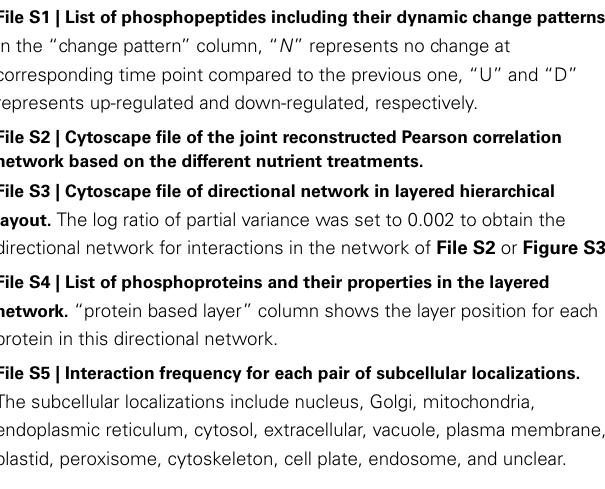
Figure S2 |Distribution of Pearson correlation coefficients associated with the actual experimental data (black) and randomized data (red lines, 1000 randomizations). Figure S3 | Subcellular location pair frequency network derived from AtPIN and SUBA. The width of each edge is proportional to its frequency. Cytoscape was used to visualize the network. Predicted interactions can be scored by how likely they are given the expected interaction frequencies displayed here.